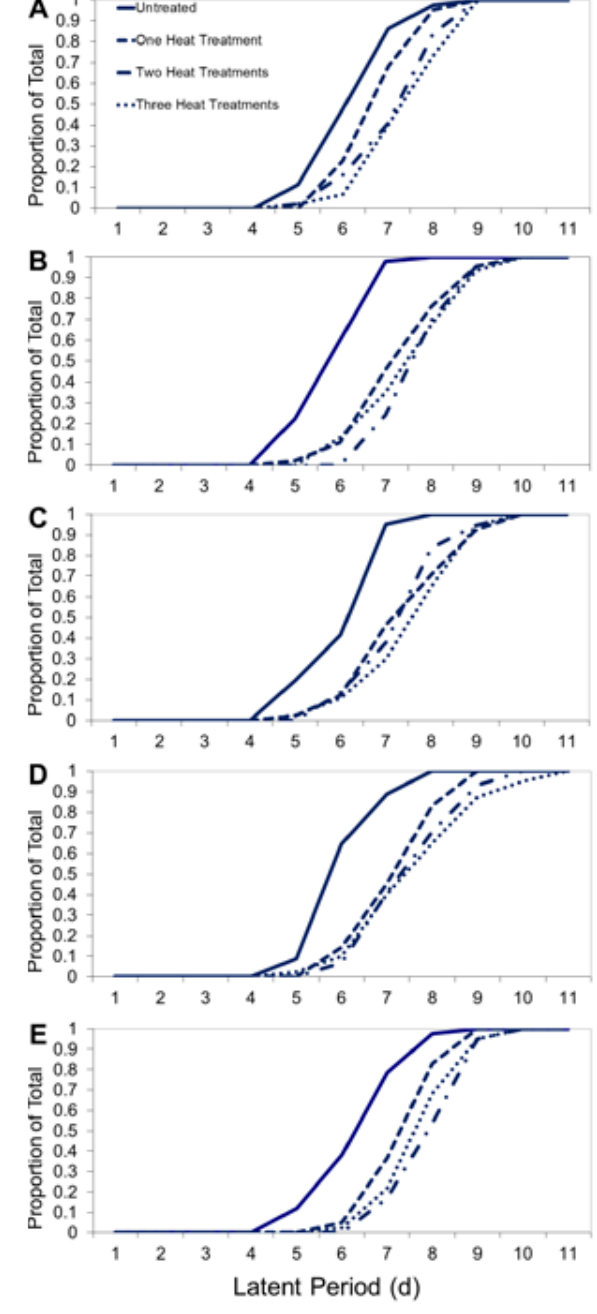
Figure 1. Erysiphe necator colony diameter growth for dif- ferent temperature and heat exposure groups at A) 31°C, B) 33°C, C) 35°C, D) 37°C, and E) 39°C. Points represent true means ± the standard error of the